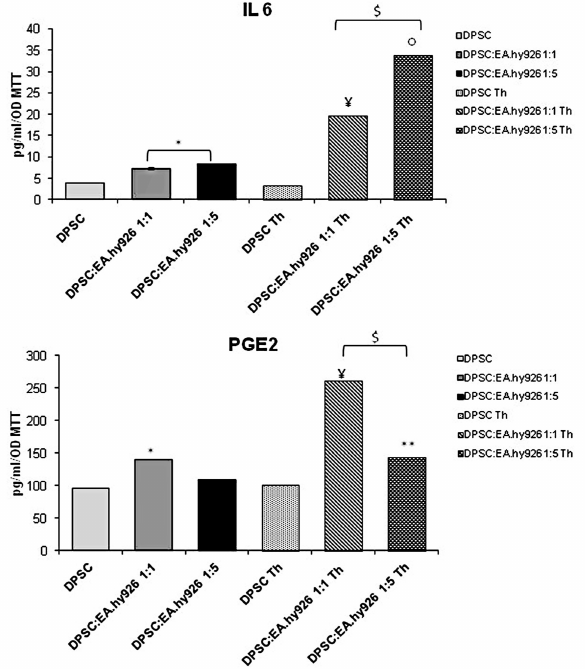
Figure 3. ELISA assay for the IL-6 (upper graph) and PGE2 (lower graph) secretions of cultures at di ff erent time points. The secretion levels are reported as pg / mL / OD MTT values. The data shown are the mean ( ± SD) ( n = 3).* DPSC:EA.hy926 1:1 and 1:5 vs. DPSC, p < 0.05; $ DPSC:EA.hy926 1:1 Th and